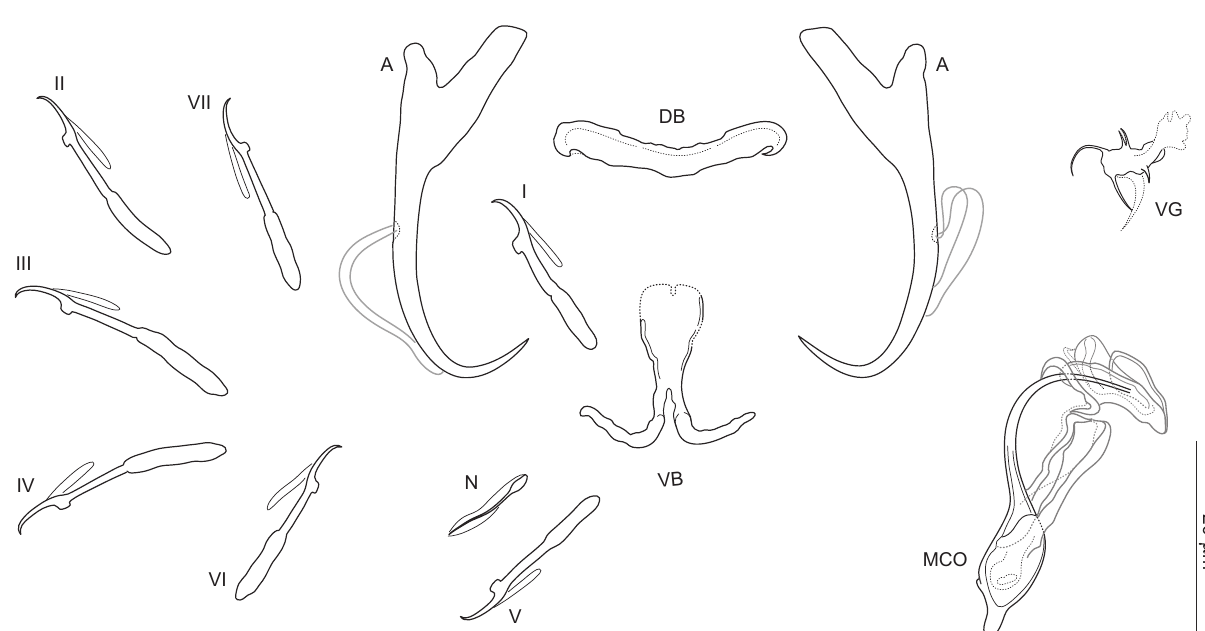
Figure 10. Sclerotized structures of Dactylogyrus octopus n. sp. ex Tropidophoxinellus spartiaticus . A, anchor; DB, dorsal bar; VB, ventral bar; N, needle; I – VII, hooks; VG, vagina; MCO, male copulatory